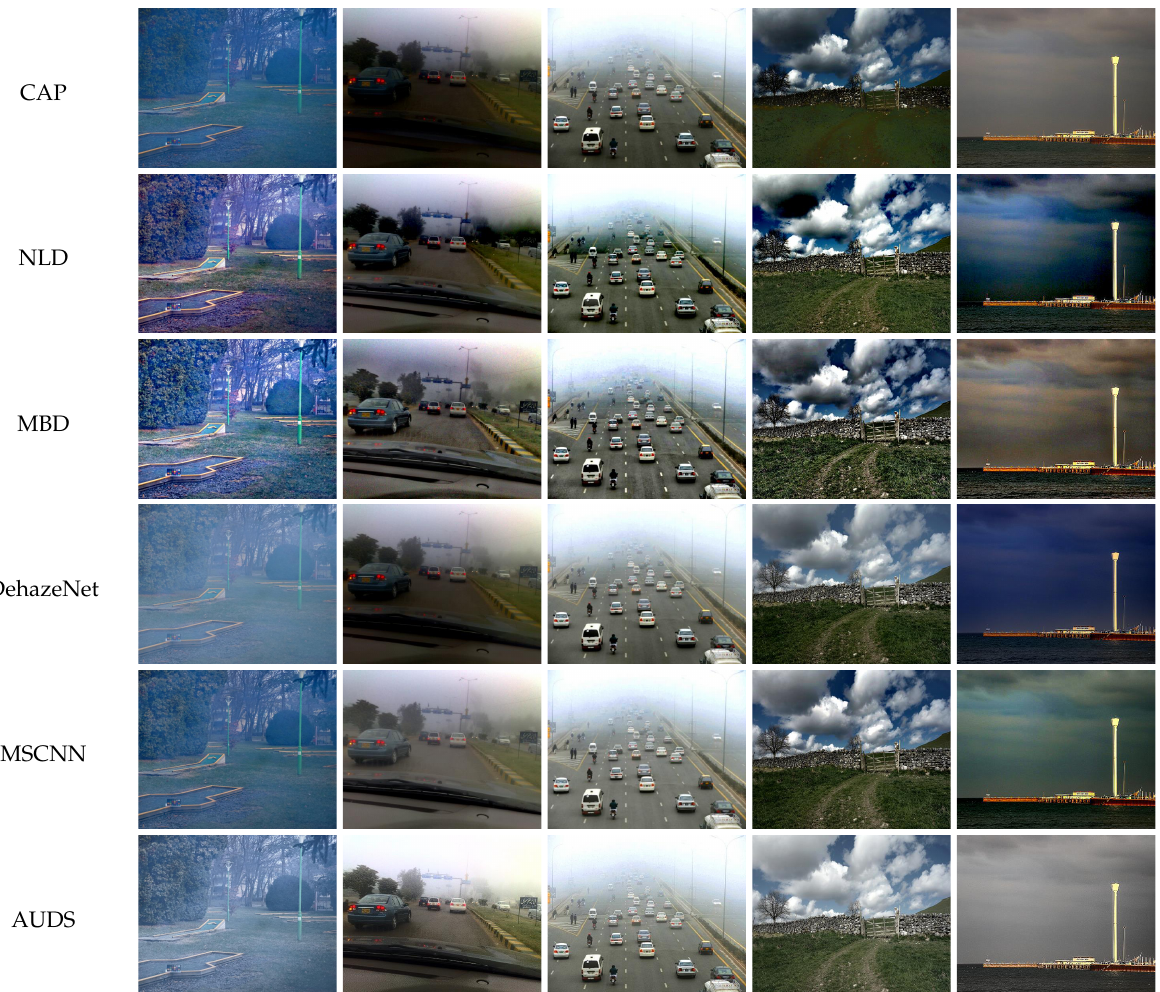
Figure 7. Qualitative comparison of the proposed AUDS with state-of-the-art benchmark methods on different images. Results of FFD, DCP, CAP, DehazeNet, and MSCNN in the ( b ) column are adopted from Ngo et al.